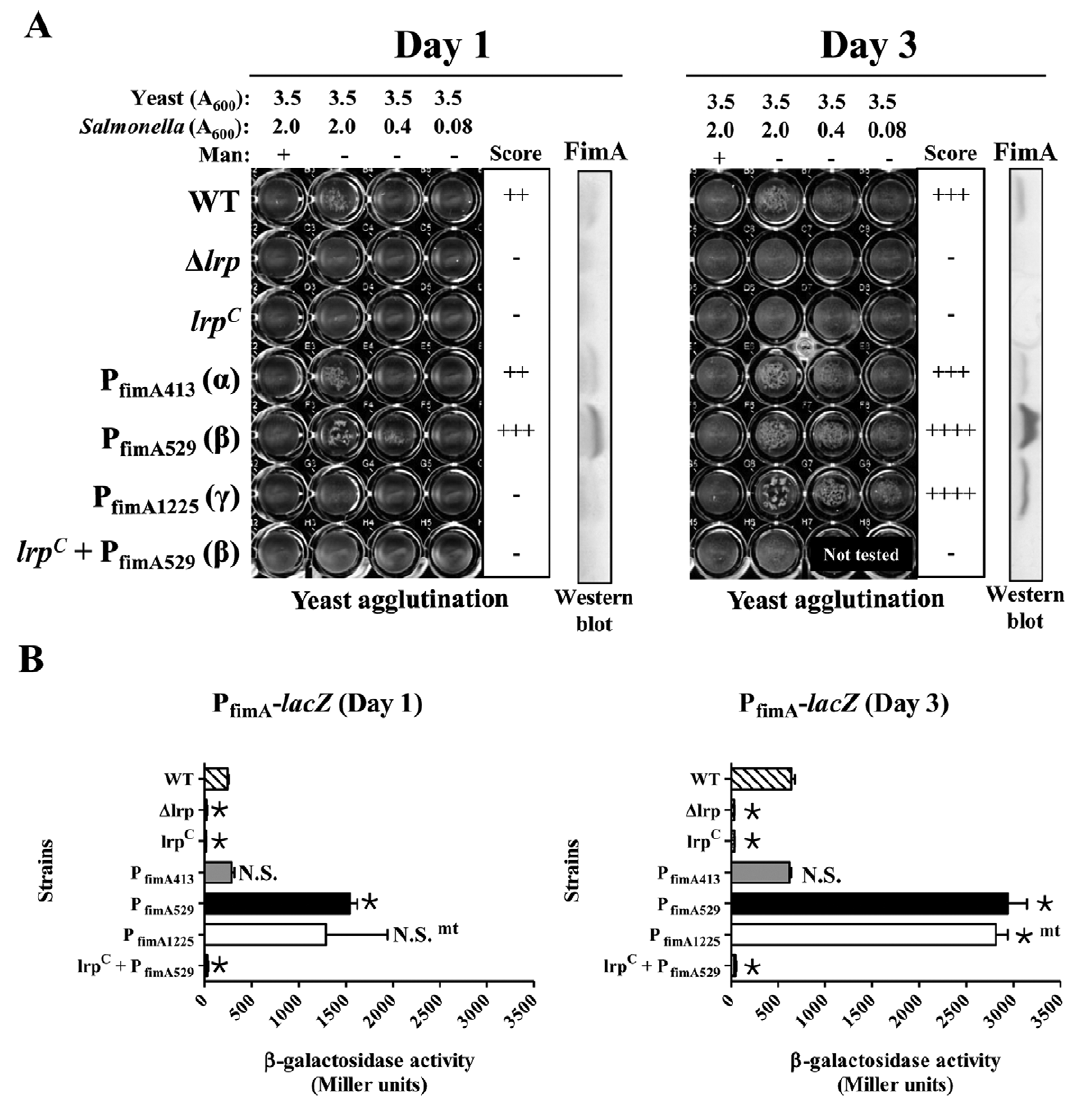
Figure 4. Effect of Lrp-binding motif mutations in P fimA on type 1 fimbriae production and b -galactosidase synthesis directed by P fimA promoter fusions in the indicated Salmonella strains. Salmonella strains each harboring one of the P fimA mutations were statically grown in LB broth at 37 u C for one day (24 h) or 3 days. Mannose-sensitive yeast agglutination assay and western blot analysis were performed to monitor fim expression in the single mutants (A). Agglutination was scored as follows: -, none; ++ , good; +++ , strong; and ++++ , very strong. Immunoblots using anti-FimA serum in each panel determine the level of FimA synthesized in each mutant. (B) b -galactosidase assay for a each lacZ fusion strain is shown. *, P , 0.05; N.S., not significant.